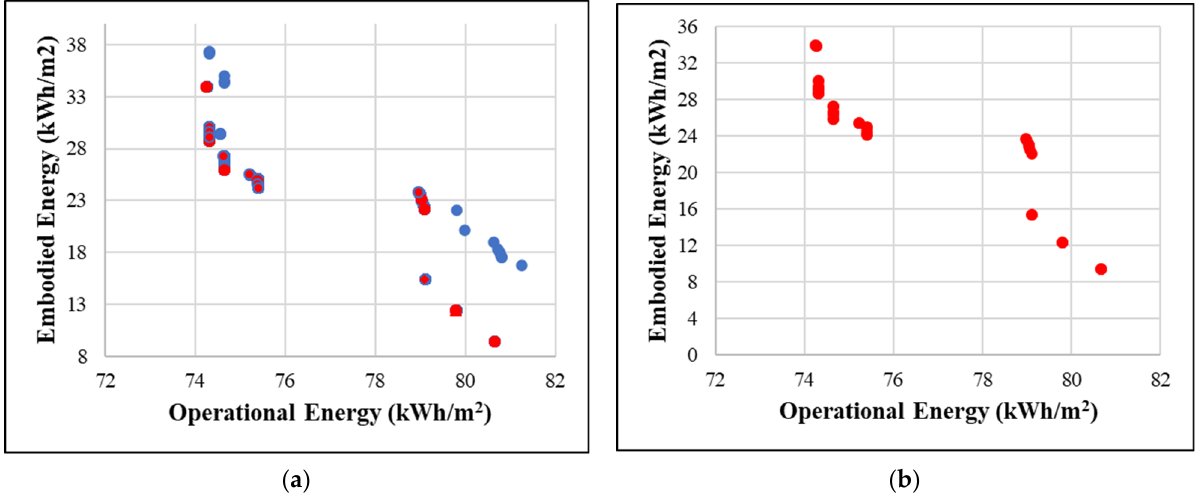
Figure 12. Scatterplot of operational energy use against embodied energy use (Ouagadougou, Burkina Faso). ( a ) Entire solution space, ( b ) Pareto optimal solutions.